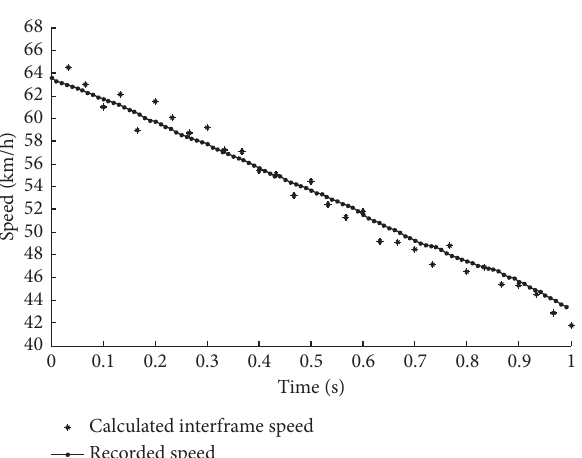
Figure 25: Compared analysis between v